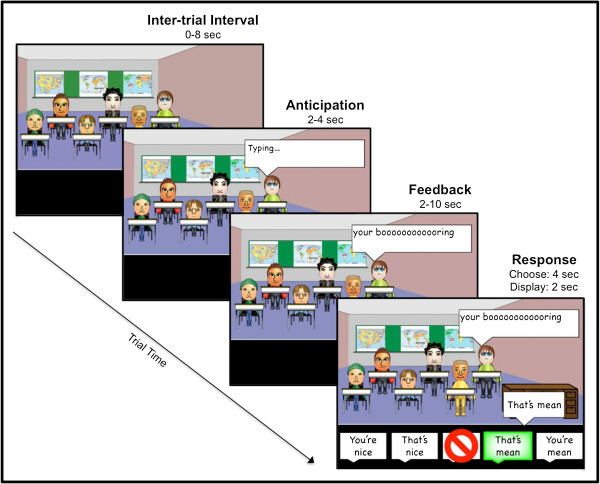
Timeline of a trial.